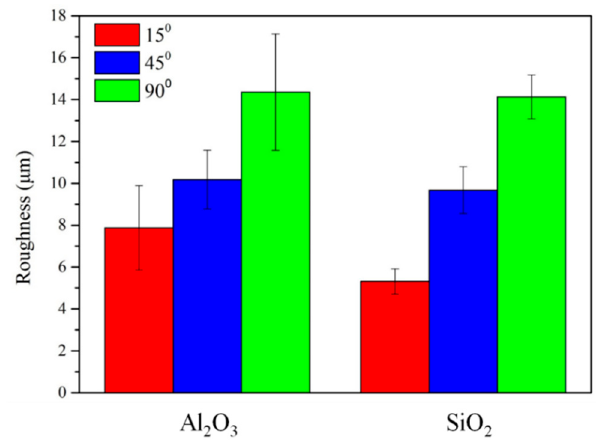
Figure 13. Surface roughness of XK105-H after erosion test.